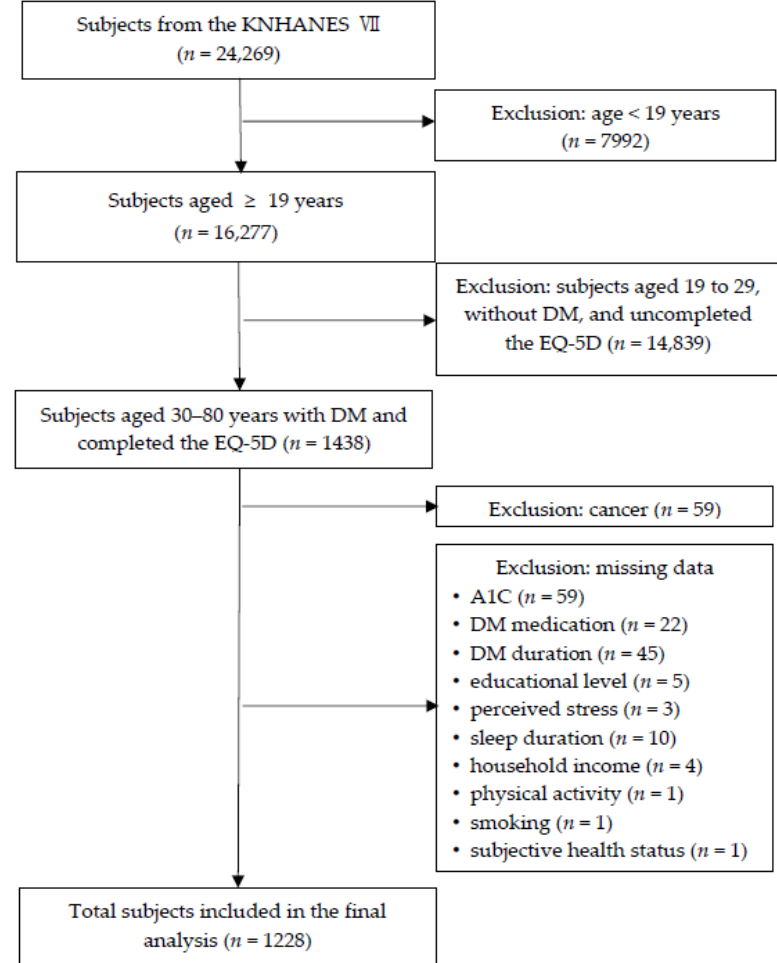
Figure 1. Flow chart diagram showing selection of the study population. KNHANES VII: Seventh Korea National Health and Nutrition Examination Survey; DM: diabetes mellitus; EQ-5D: Euro Quality of Life Five Dimension; A1C: glycated hemoglobin.